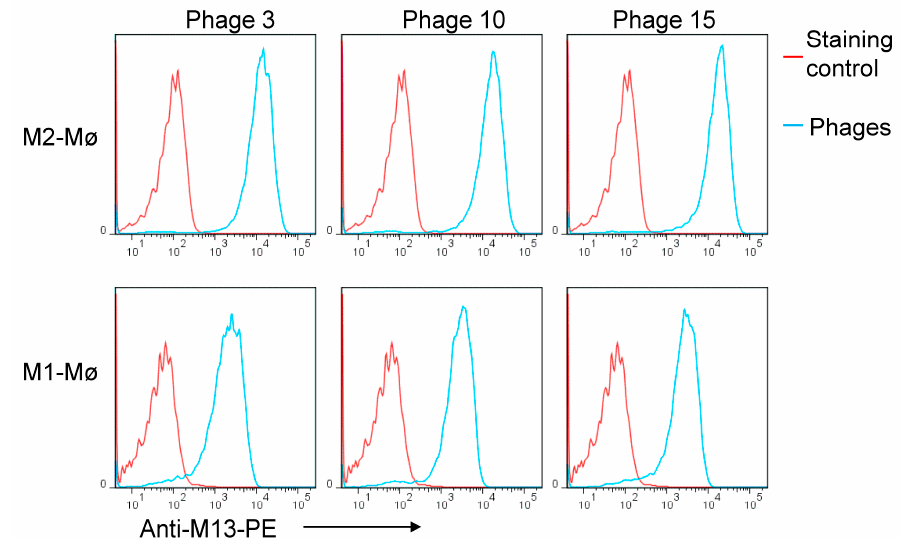
Figure 2. Binding of single phage clones to M1 and M2 macrophages. Representative examples of flow cytometry histograms showing the binding of single phage clones from round 3 to M1 and M2 macrophages. All tested phage clones bound to M1 and M2 macrophages with high affinity.